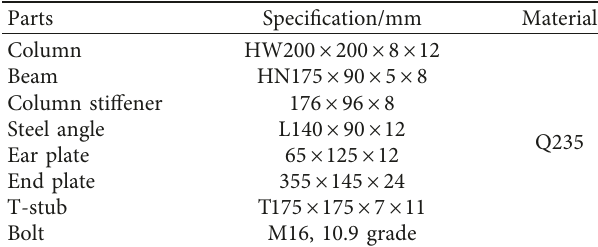
Figure 4: Joint details. (a) J-1. (b) J-2. (c) J-3. Table 2: Specification and material of the specimens.